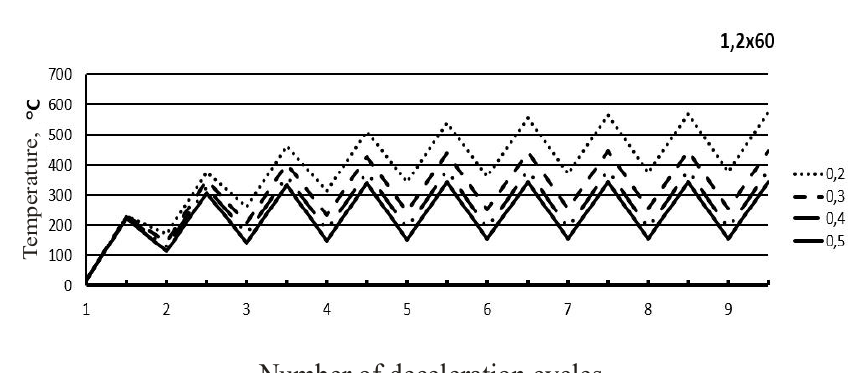
Fig. 5. Quasi-stationary temperature exit curves for resistive elements made of fechral tape with a cross section of 1,2 * 60 mm 2 (the numbers of heating and cooling cycles of resistive elements are shown at the abscissa